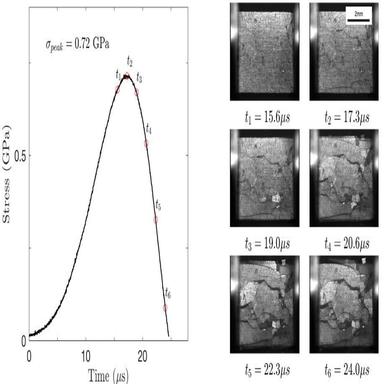
Stress-time history of dynamic uniaxial compression of thermally damaged boron carbide with time resolved high speed video images. Note the difference in y-axis scale from the previous figure.